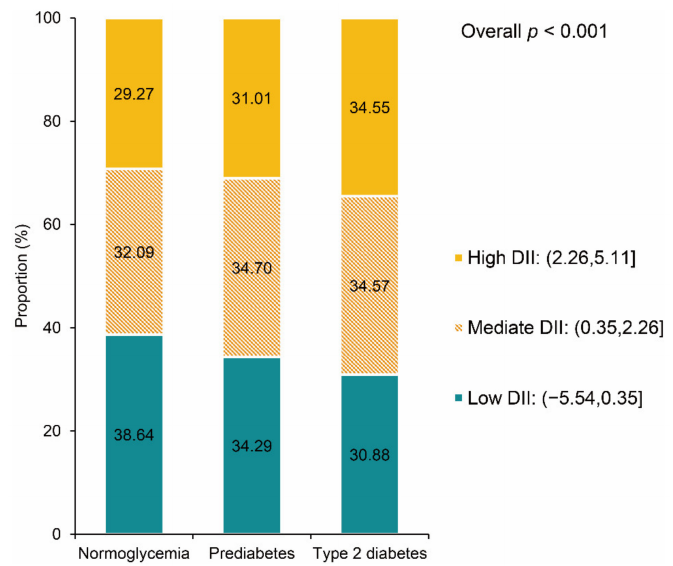
Figure 2. DII distribution by baseline glycemic status. DII: dietary inflammatory index. Participants with type 2 diabetes had higher scores in alcohol, fiber, MUFA, PUFA, niacin, thiamin, riboflavin, vitamin B6, vitamin C, vitamin E, Mg, Zinc, Selenium, folic acid, N-3 fatty acids, and N-6 fatty acids (Figure 3, Table 2). We also noticed lower scores of participants with type 2 diabetes in certain components, such as carbohydrates, protein, total fat, saturated fat, vitamin B12, Fe, and energy. When compared to the normoglycemia group, the DII component scores remained consistent between participants with prediabetes and type 2 diabetes but to a lesser extent in the former.